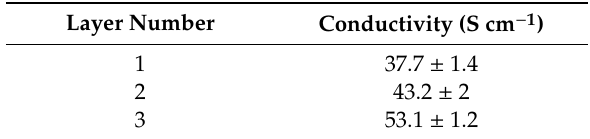
Table 1. Conductivity associated with number of PEDOT/TOS layers.